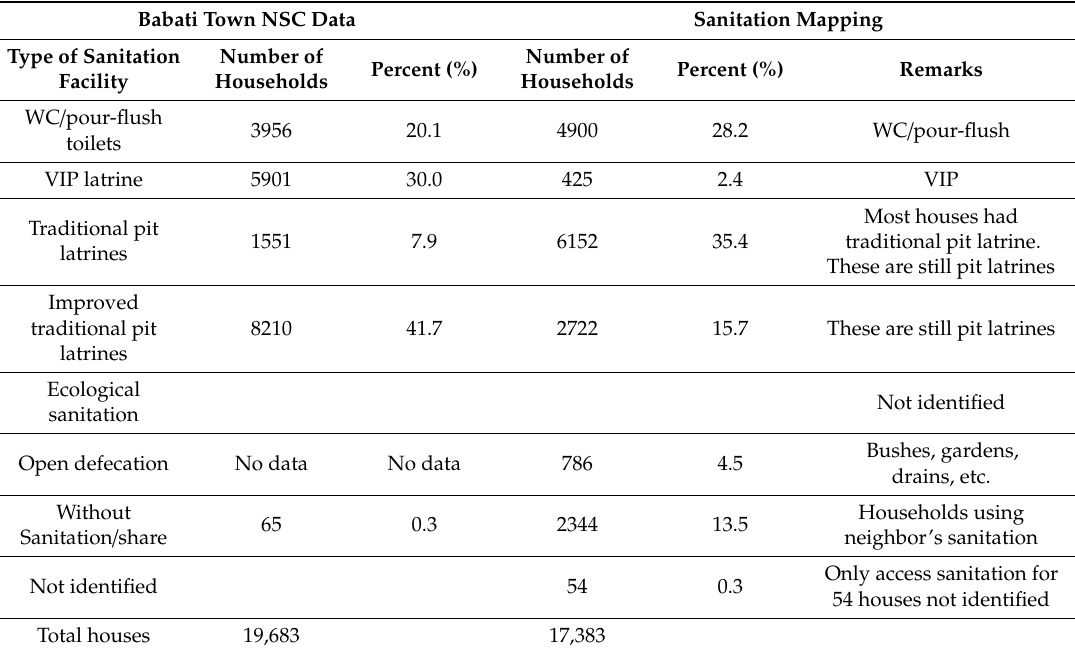
Table 2. Distribution of sanitation facilities as per the JMP sanitation service ladder (source: NSC database and this study).